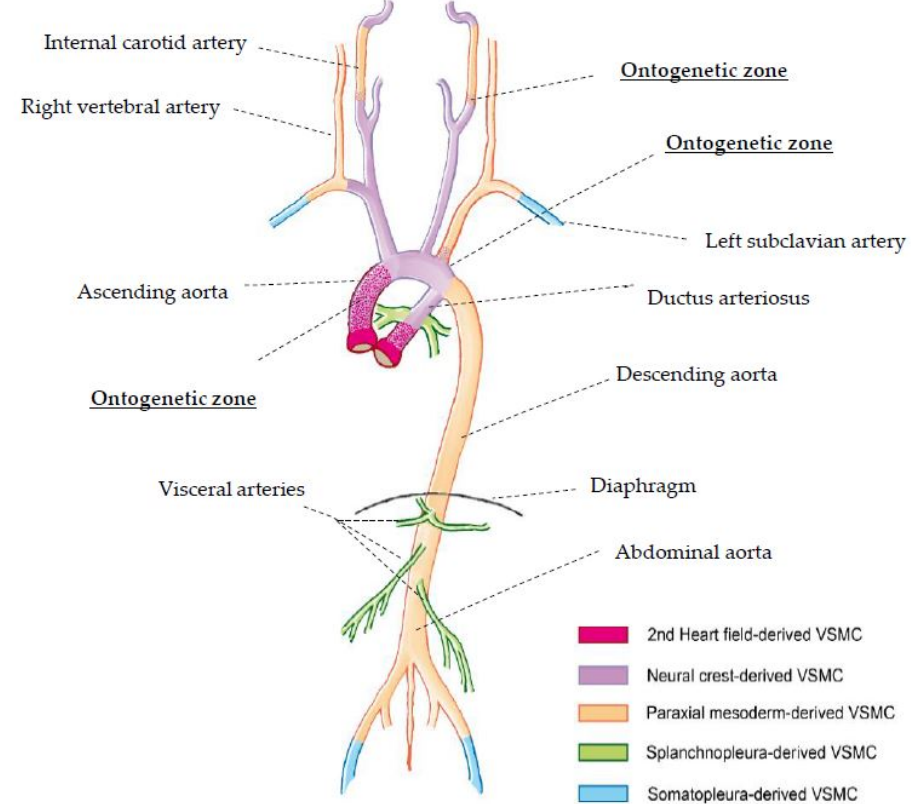
Figure 2. Embryologic origin of vascular smooth muscle cells (VSMCs). Ontogenetic zones are illustrated in dotted coloration and considered as predilected sites for vascular pathologies. This schematic drawing depicts the regional differences in the embryonic origin of smooth muscle cells (synthetic, contractile) forming the tunica media of the wall of the aorta and its main branches. Data are based on fate-mapping studies in mouse and chick embryos [29–35]. There is compelling evidence that regional differences in the embryonic origin of vascular smooth muscle cells (VSMCs) contribute to regional differences in structure, physiology and pathology of the arterial vasculature [36,37]. Boundaries between arterial tunica media segments derived from different embryonic sources seem to be predilection sites for vascular pathologies (e.g., aortic coarctation). With regard to arterial dissections, we should point to the peculiar border between the populations of mesoderm-derived (second heart field) VSMCs and neural crest-derived VSMCs within the wall of the ascending aorta (Stanford type A aortic dissection). The latter VSMC population forms the inner layers of the tunica media, whereas the former population forms the outer layers (see inset). Further boundaries between neural crest-derived segments of the arterial tunica media and mesoderm-derived (paraxial mesoderm) segments are found at the border between the aortic arch and the descending aorta (Stanford type B aortic dissection) and along the course of the internal carotid arteries (CeAD).